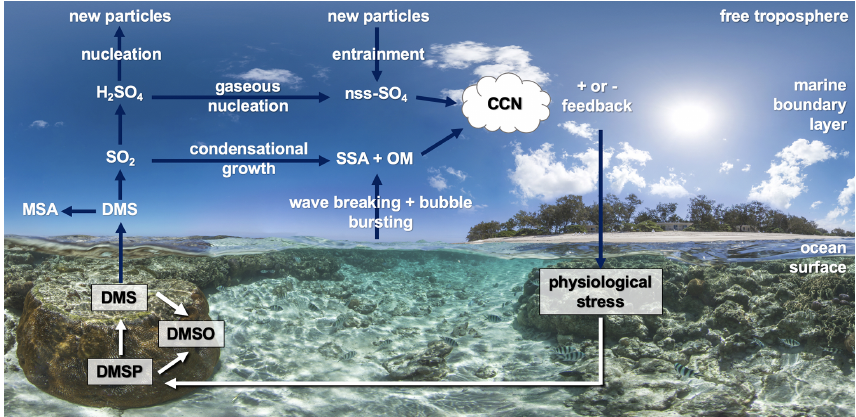
Figure 4. Simplified overview of the coral-reef DMS-aerosol–cloud feedback (DMS – dimethylsulfide). Dimethylsulfoniopropi- onate (DMSP) is produced by the coral holobiont and may be oxidised to dimethyl sulfoxide (DMSO) or cleaved to DMS. Atmospheric DMS is oxidised to sulfate aerosol precursor compounds including methane sulfonic acid (MSA) and sulfur dioxide (SO 2 ) and secondarily to sulfuric acid (H 2 SO 4 ), which may condense onto existing particles (e.g. sea-spray aerosol – SSA – or organic matter – OM) or nucleate to non-sea salt sulfate particles (nss − SO 4 ). These may increase the number of cloud condensation nuclei (CCN) and increase cloud life- time and albedo. Background image: http://catlinseaviewsurvey.com/gallery/i853_lady-elliot-island-australia/ (last access: 2 March 2020), © Underwater Earth/XL Catlin Seaview Survey/Aaron Spence/CC BY-NC-SA